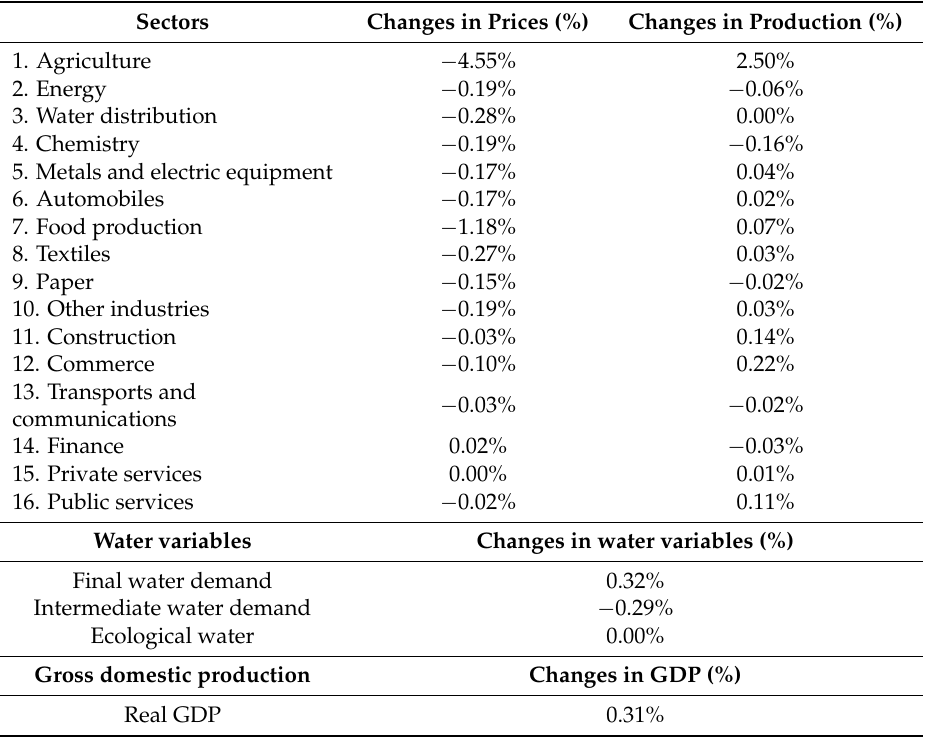
Table 1. Simulation 1: 25% increase in TPF of agriculture (without water